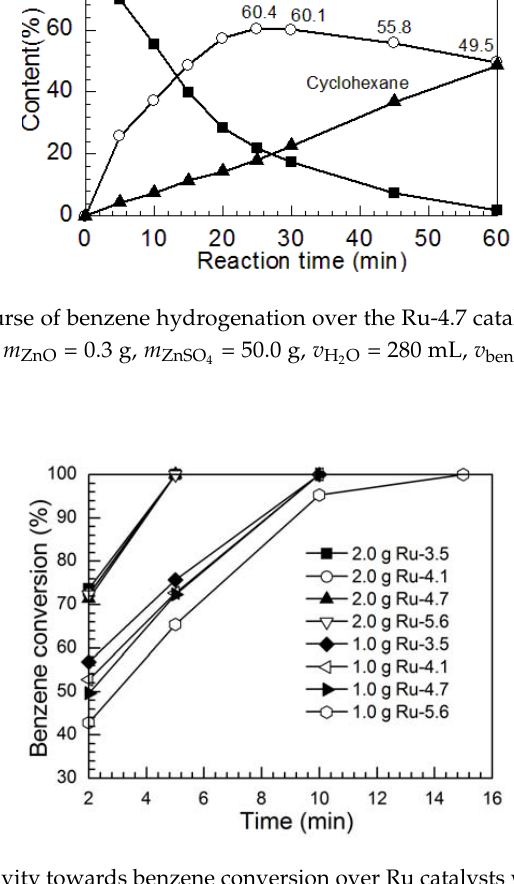
Figure 13. Catalytic activity towards benzene conversion over Ru catalysts with the different particle size for hydrogenation of benzene without any additives ( v H2O = 280 mL, v benzene = 140 mL, T = 423 K, p H2 = 5.0